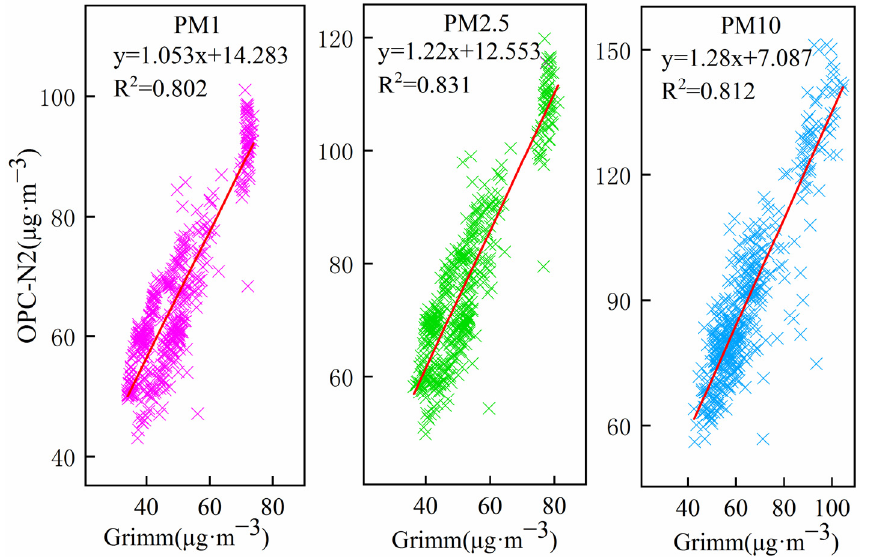
Figure 5. Correlation analysis results of OPC ‐ N2 and Grimm for ambient air PM concentrations in outdoor monitoring.